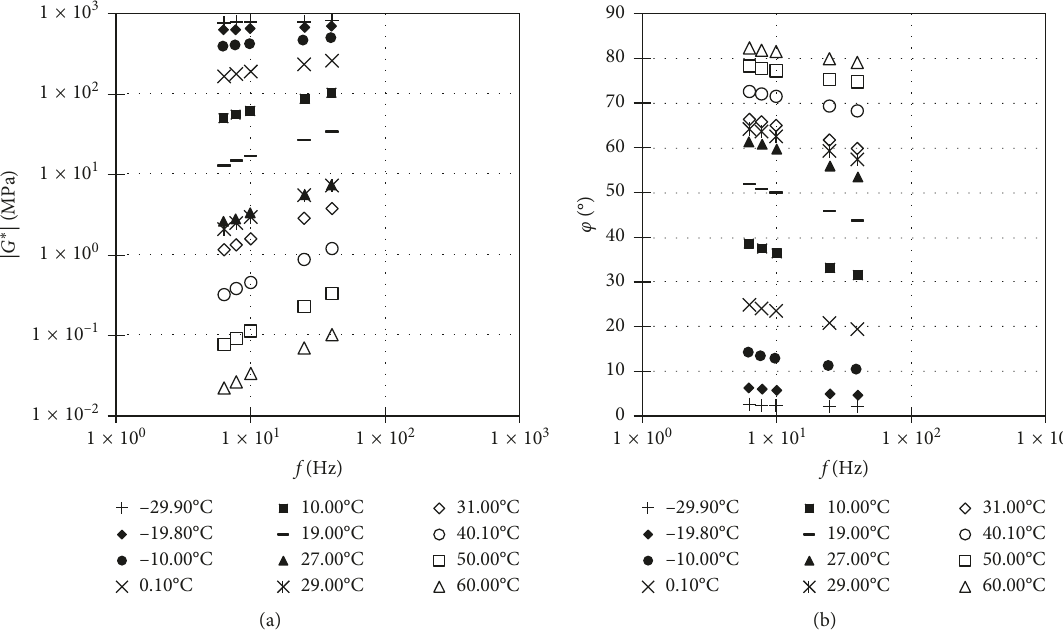
Figure 2: Experimental data of the bitumen given to calibration panel: isotherms of norm (a) and phase angle (b) of complex shear modulus G